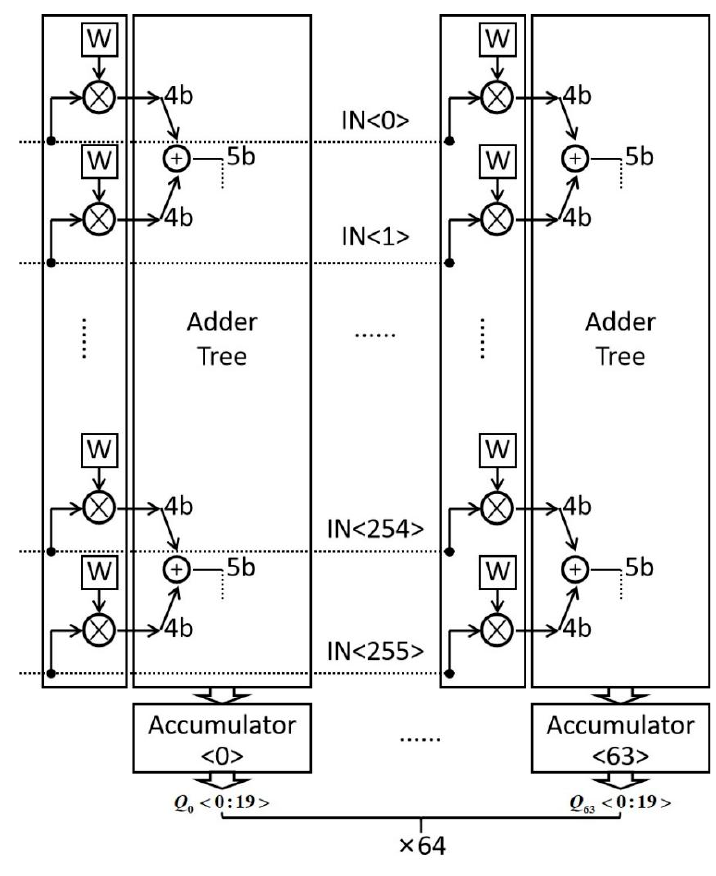
Figure 1. Illustration of the typical digital CIM design.